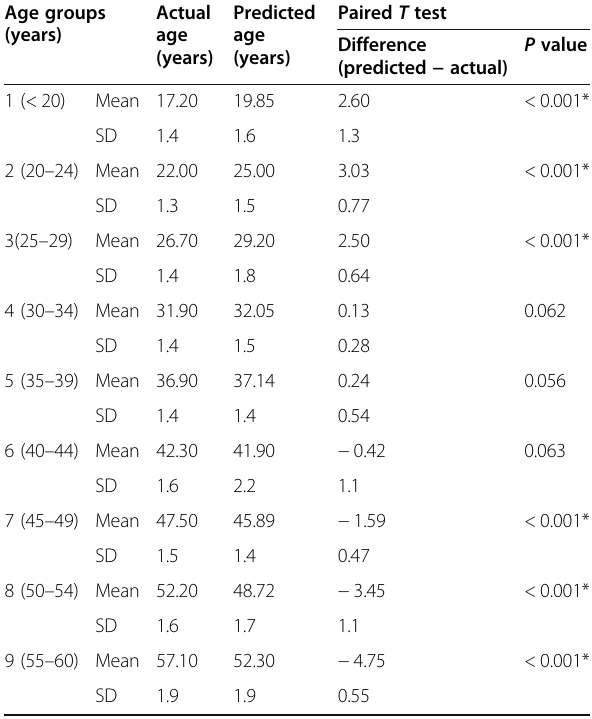
Table 4 Comparison between the actual and predicted age in the validation sample ( N =